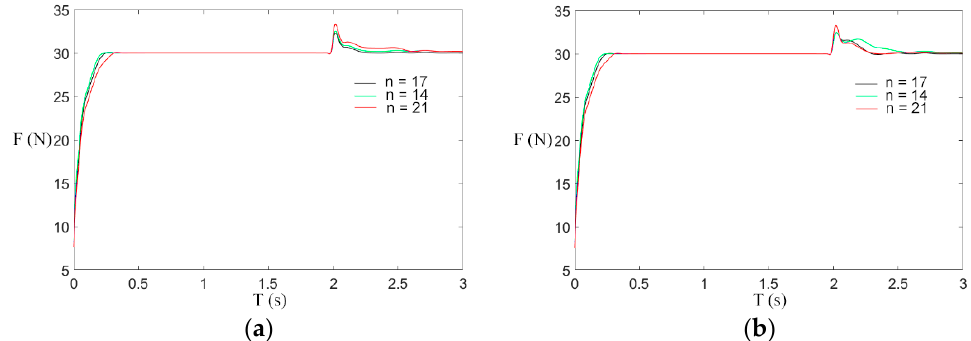
Figure 19. Tension response of the different number of guide rollers. ( a ) Situation 1; ( b ) Situation 2.